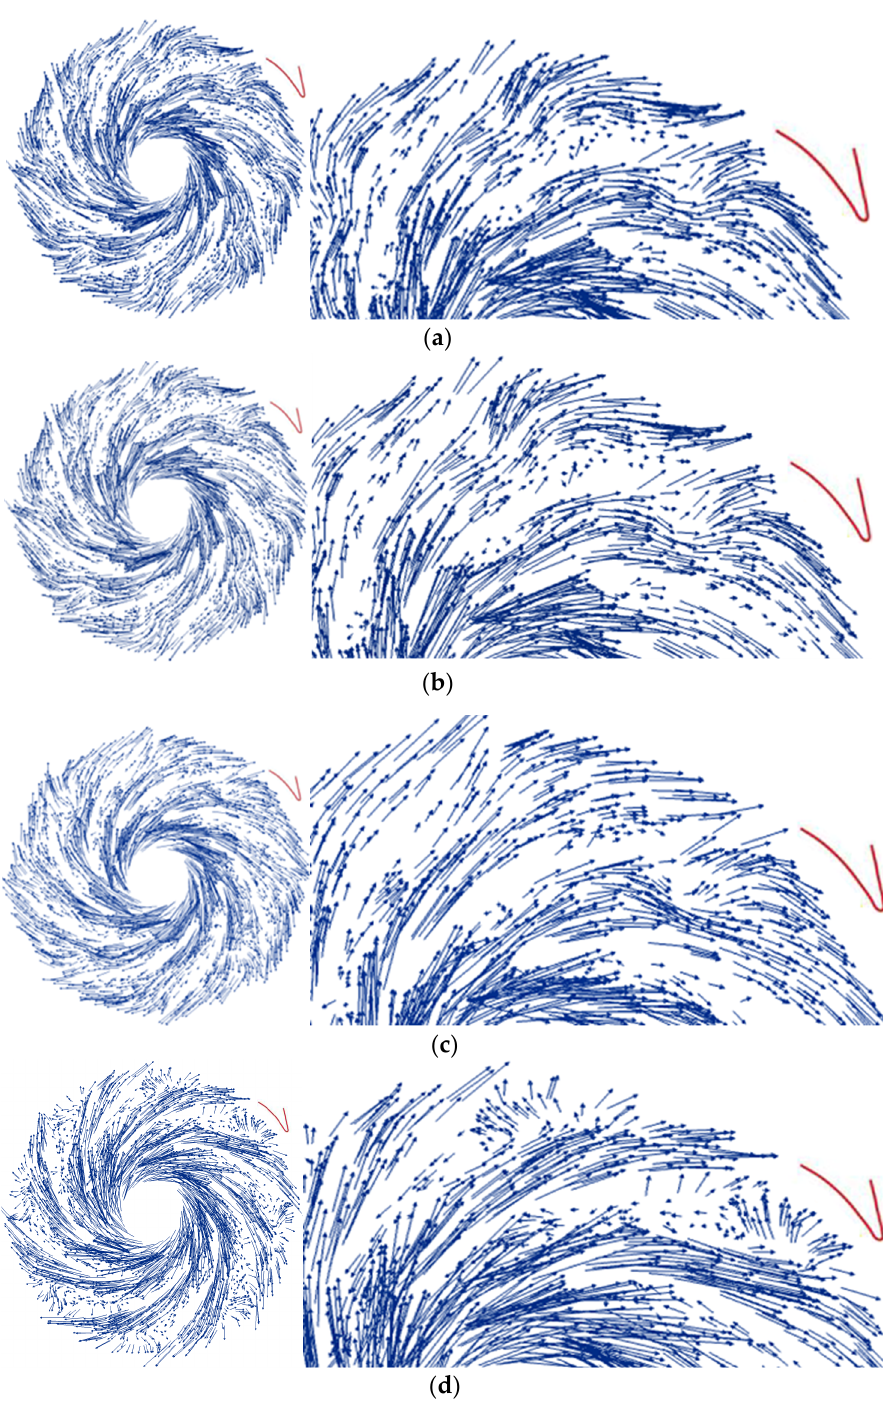
Figure 10. Relative velocity vector diagrams in the impeller. ( a ) NPSHa = 1.67 m; ( b ) NPSHa = 1.32 m; ( c ) NPSHa = 1.05 m; ( d ) NPSHa = 0.65 m.